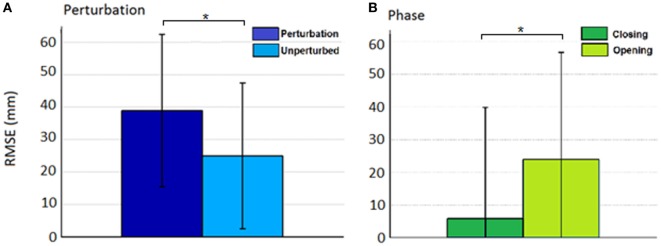
Root mean squared error (RMSE) for the effect of (A) condition (perturbed/unperturbed) and (B) phase (closing/opening).